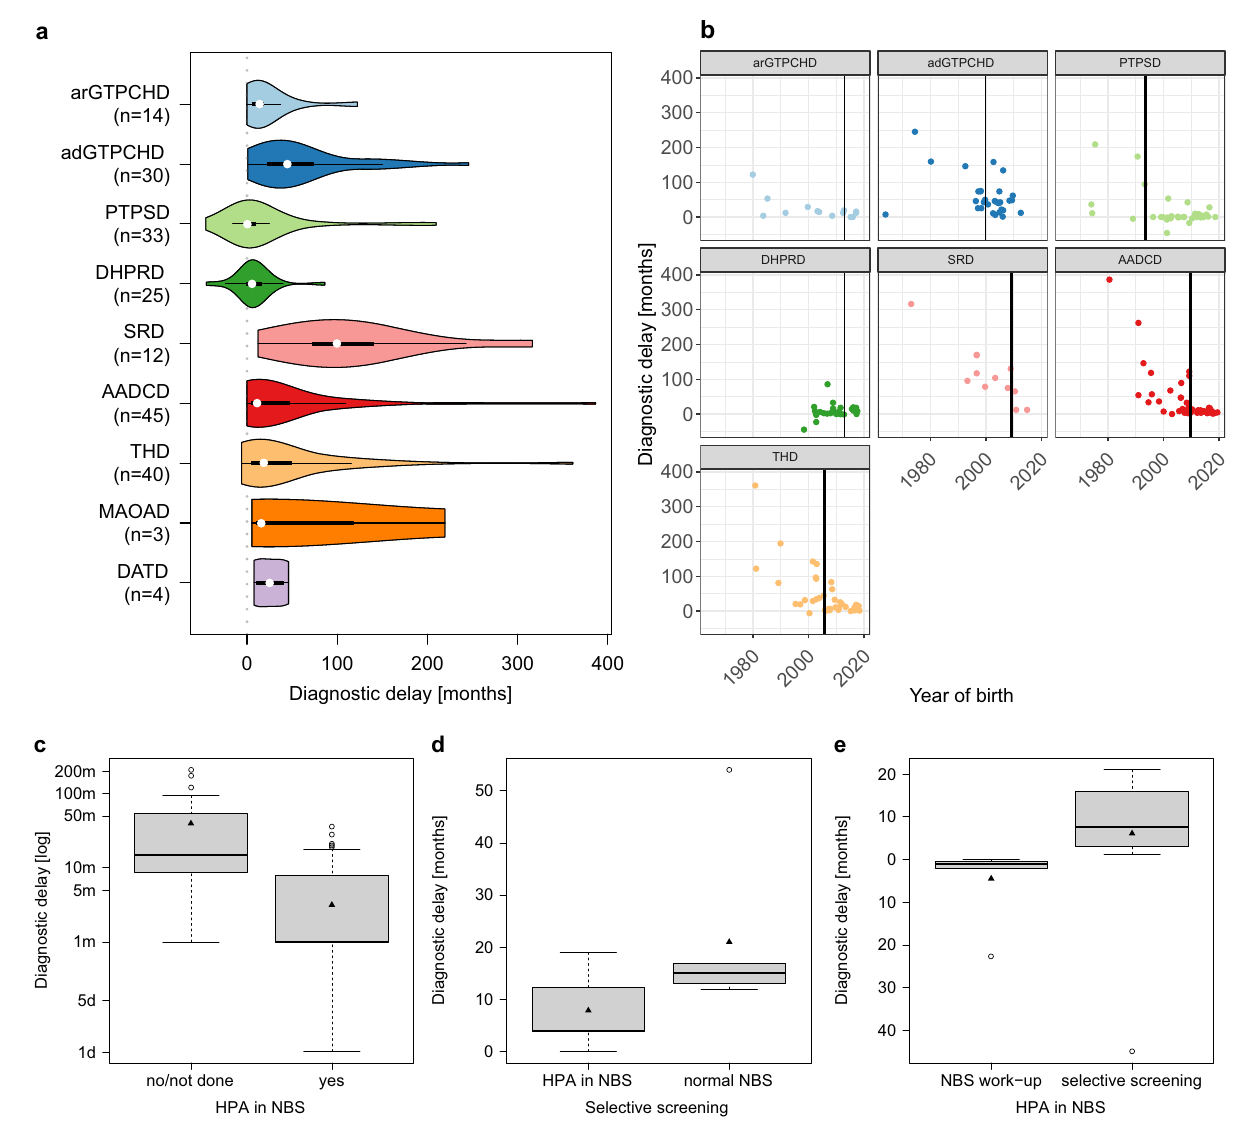
Fig. 4 Effects on diagnostic delay in different diseases. a Diagnostic delay in disorders of biogenic amine metabolism and BH de fi ciencies. White spot: median, black bars: interquartile range (25% and 75%), n: number reported. b Effect of date of birth on diagnostic delay; bold line: signi fi cant, two-sided WMW-test, p < 0.05, c Diagnostic delay in arGTPCHD, PTPSD and DHPRD in patients without any or normal newborn screening (NBS) results ( n = 24) vs. patients with hyperphenylalaninemia (HPA) on NBS ( n = 47); two-sided t -test, p = 0.006. d Diagnostic delay in arGTPCHD regarding HPA on NBS ( n = 5) vs. normal NBS ( n = 6); two-sided t -test, p = 0.11. e Diagnostic delay in DHPRD in patients having HPA on NBS diagnosed directly after NBS ( n = 6) vs. via selective screening ( n = 14); two-sided t -test, p = 0.08. Diamond: arithmetic mean, bold line: median, boxes present interquartile range (25% and